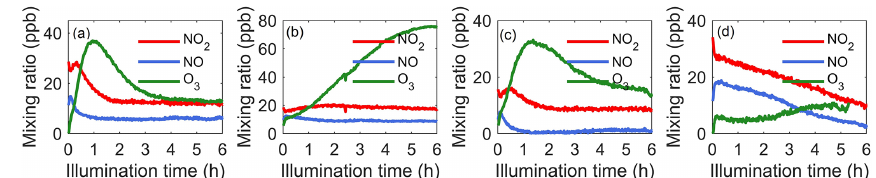
Figure 1. NO 2 , NO, and O 3 time series in example single-VOC and mixed-VOC experiments with (a) α -pinene, (b) isoprene, (c) α -pinene– isoprene, and (d) o -cresol. Note that, in the presence of o -cresol, O 3 measurement by UV absorption was influenced by UV absorption by o -cresol, and O 3 data in (d) were corrected as explained in the Methodology section.